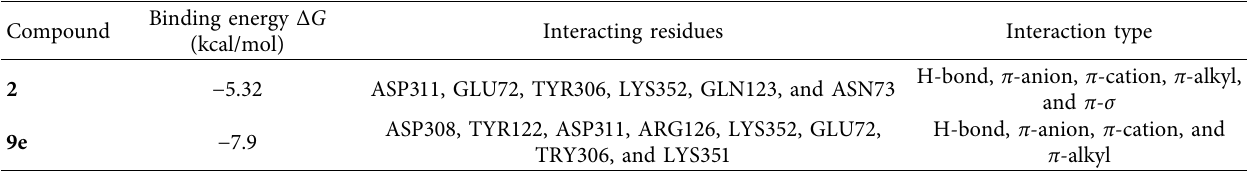
Table 2: The docking parameters of 2 and 9e using the STAT3 hotspot.